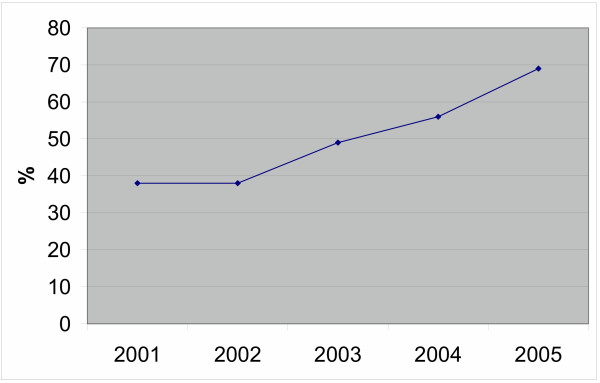
Public support for completely smokefree pubs and bars. National survey data from UMR Research Ltd [26].